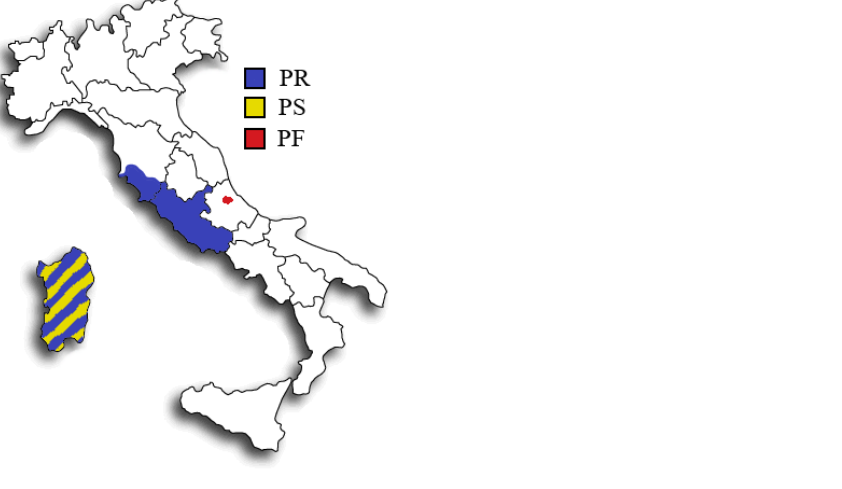
Figure 1. Geographical origin of Pecorino Romano (PR), Pecorino Sardo (PS), and Pecorino di Farindola (PF).